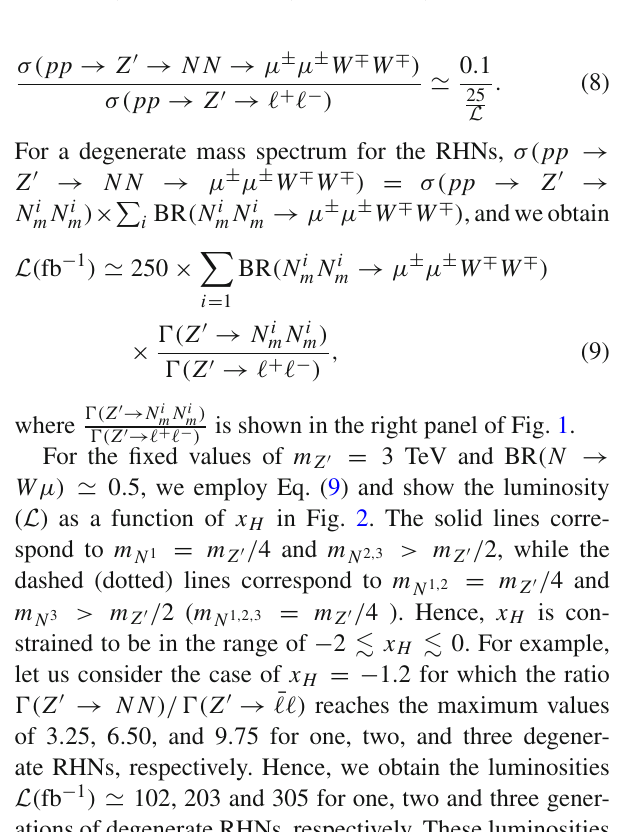
Fig. 2 The plot shows the luminosity required to obtain 25 signal events of the Z (cid:2) boson as a function of x H , for fixed values of m Z (cid:2) = 3 TeV and BR ( N → W μ) (cid:6) 0 . 5. The solid lines correspond to m N 1 = m Z (cid:2) / 4 and m N 2 , 3 > m Z (cid:2) / 2; the dashed (dotted) lines corre- spond to m N 1 , 2 = m Z (cid:2) / 4 and m N 3 > m Z (cid:2) / 2 ( m N 1 , 2 , 3 = m Z (cid:2) / 4)